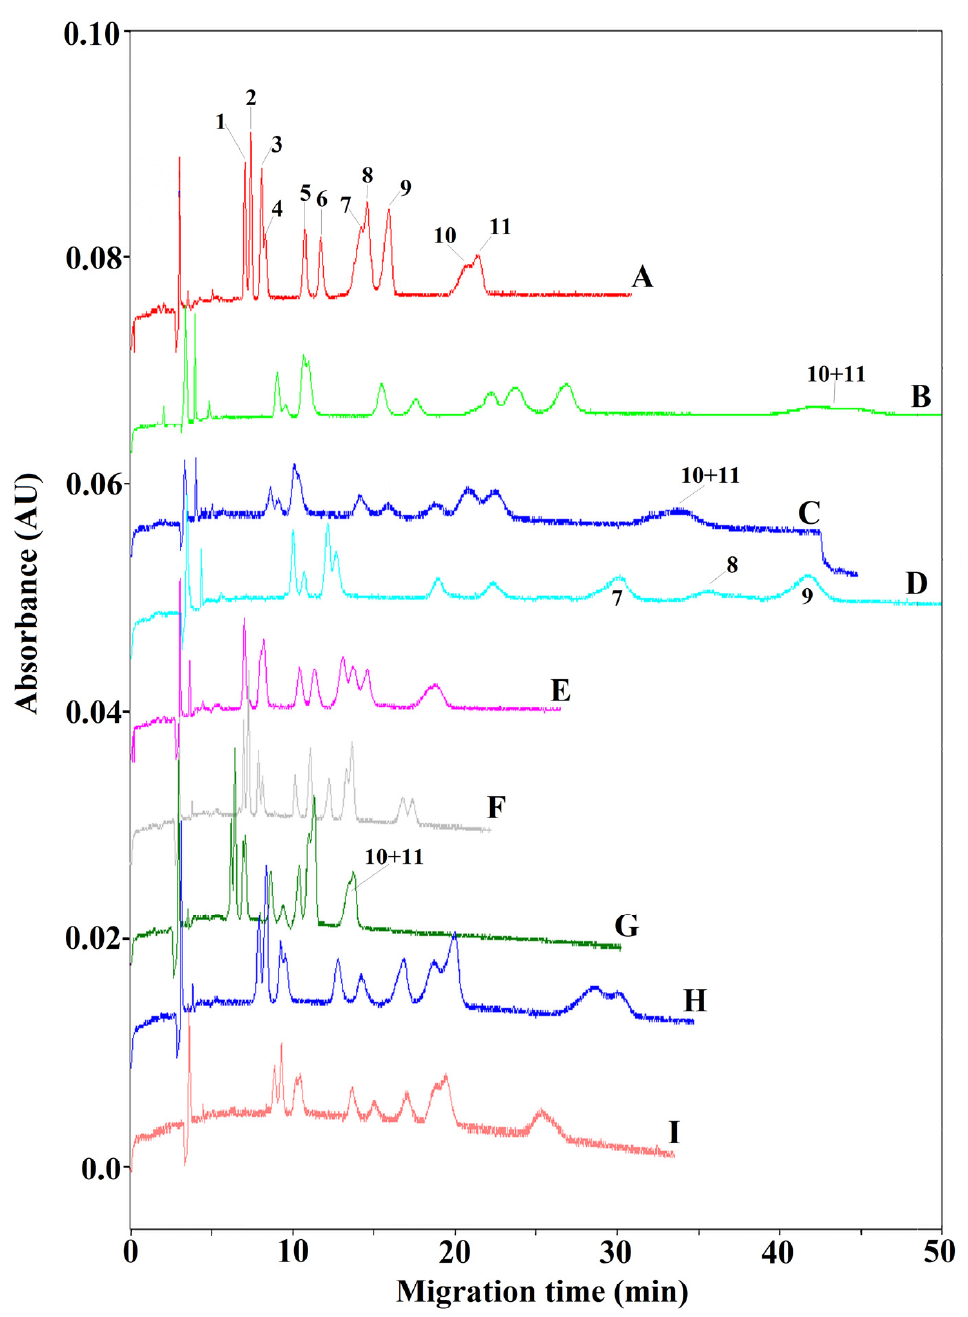
Figure 3. Separation of nucleotides in modified capillaries. Conditions: 5 kV, 20 °C, normal polarity, running buffer 0.05 mol/L Na 2 HPO 4 + 1 mol/L HCl, pH 7.40, injection 3 s. ( 1 ) GMP, ( 2 ) AMP, ( 3 ) CMP, ( 4 ) UMP, ( 5 ) GDP, ( 6 ) ADP, ( 7 ) GTP, ( 8 ) CDP, ( 9 ) ATP, ( 10 ) CTP, ( 11 ) UTP. ( A ) Sol–gel base, n = 4; ( B ) sol–gel + curcuma extract, n = 3; ( C ) sol–gel + Moringa extract, n = 3; ( D ) sol–gel + St. John’s wort extract, n = 2; ( E ) sol–gel + mixture 1 of extracts, n = 5; ( F ) sol–gel + curcumin, n = 3; ( G ) sol–gel + hypericin, n = 4; ( H ) sol–gel + isoquercetin, n = 3; ( I ) sol–gel + mixture 2 of specific compounds, n = 4; n , number of repeated analyses in a particular